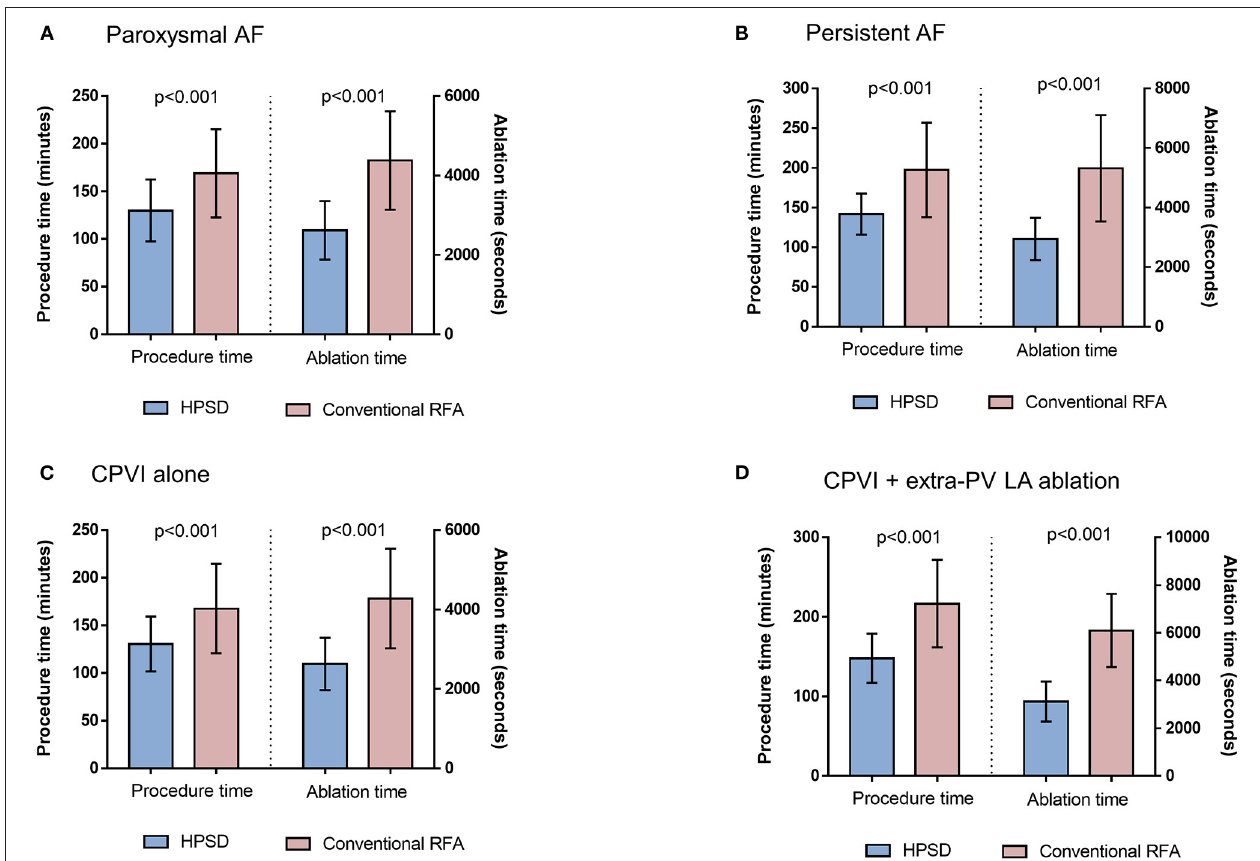
FIGURE 4 | The comparisons of procedure time and ablation time between HPSD and conventional power groups in the patients with paroxysmal AF (A) , persistent AF (B) , circumferential pulmonary vein isolation (CPVI) alone (C) , or additional extra-pulmonary vein (PV) left atrial (LA) ablation (D) . HPSD, high-power short-duration radiofrequency ablation; AF, atrial fibrillation; RFA, radiofrequency